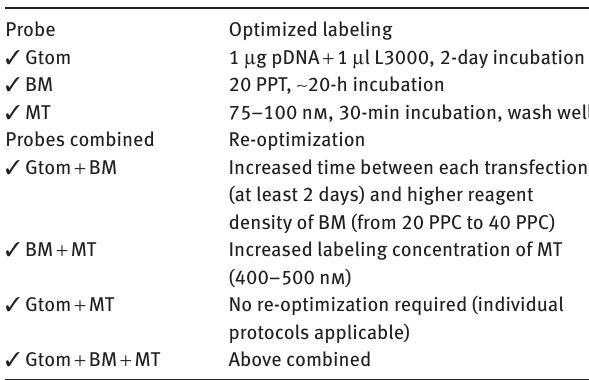
Table 1: Overview of necessary re-optimizations for multicolor labeling